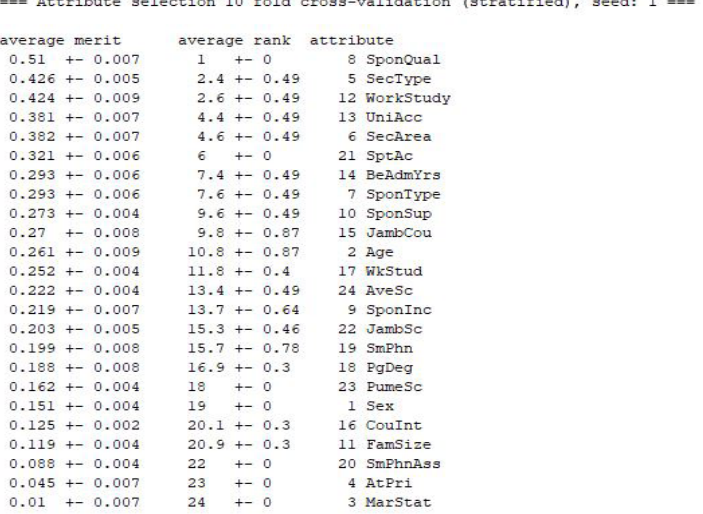
Figure 12: Results from correlation feature selection